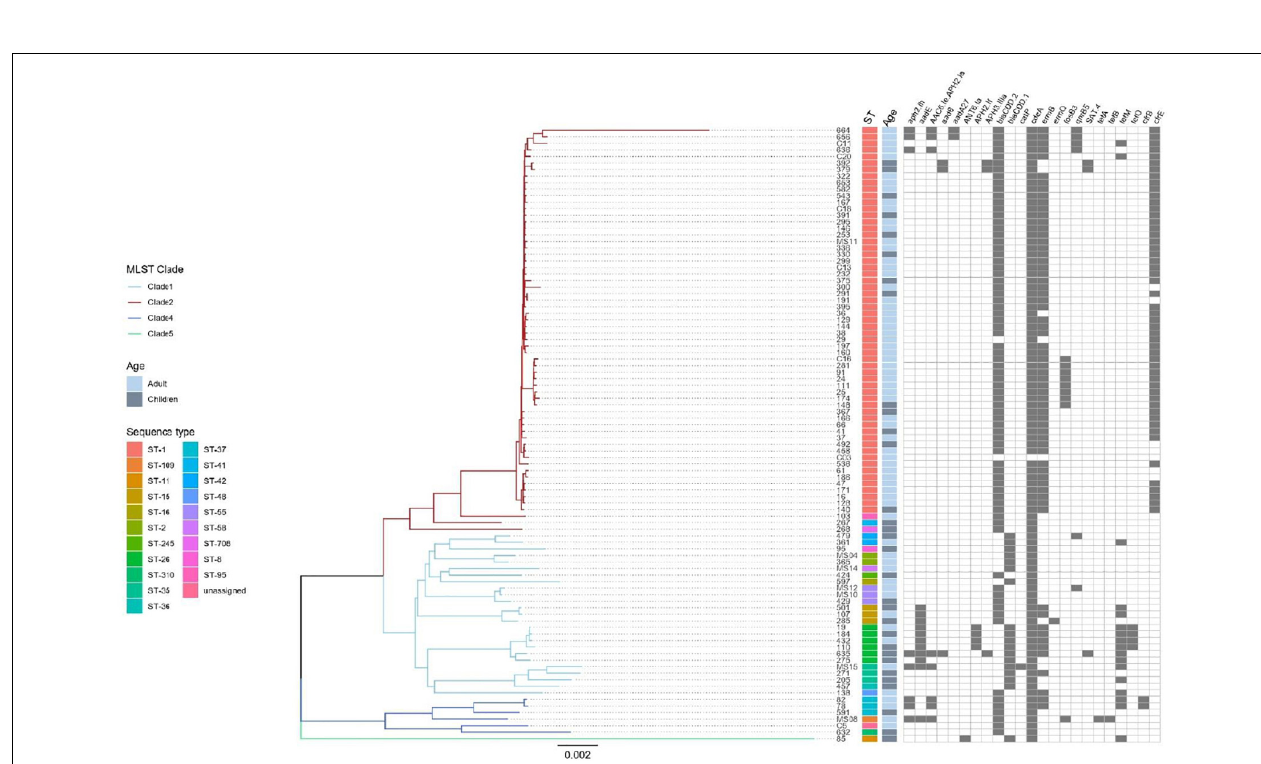
FIGURE 4 | Result of genomic analysis of 94 C. difficile strains from Mexican patients and presence of resistance associated genes. Phylogenetic tree based on whole genome sequences was constructed using virtual hybridization analysis (VAMPhyRE) and correlated with clades, STs, patient’s age and with the presence of antibiotic resistance genes. Presence is indicated by gray rectangles and absence by white rectangles.